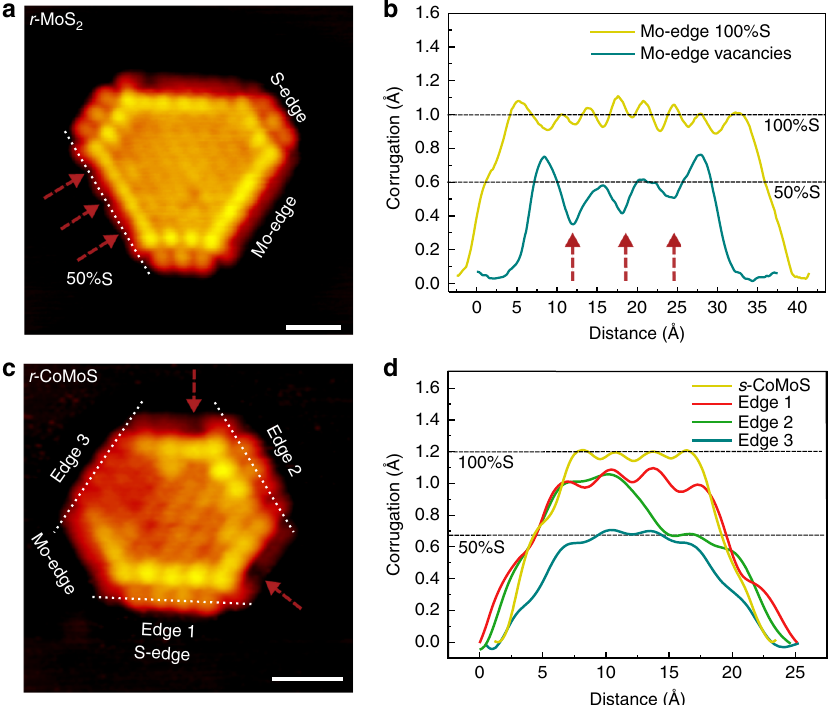
Fig. 3 Analysis of edge structures present under sulfo-reductive conditions ( r -MoS 2 and r -CoMoS). a Atom-resolved STM image of an r -MoS 2 nanocluster ( V t = − 0.32 V, I t = − 0.42nA). b Line scans along the Mo-edge as indicated on the r -MoS 2 image compared with a line scan on s -MoS 2 . Red arrows indicate the position of S vacancies within the otherwise 50% S-covered Mo-edge. Both scale bars are 1 nm. c Atom-resolved STM image of an r -CoMoS nanocluster ( V t = − 0.26 V, I t = − 0.30 nA). Red arrows again indicate sulfur vacancies in the 50% S-covered Mo-edges. d Line scans along the Co- promoted S-edge as indicated on the r -CoMoS. For reference, a line scan of the S-edge of an s -CoMoS cluster is also